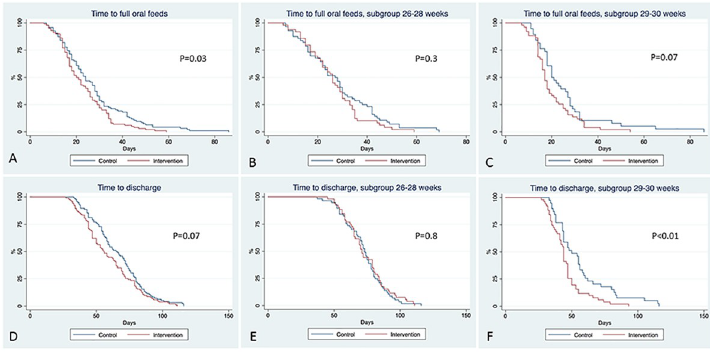
Fig 4. Kaplan-Meier curves for time to reach full oral feeds and length of